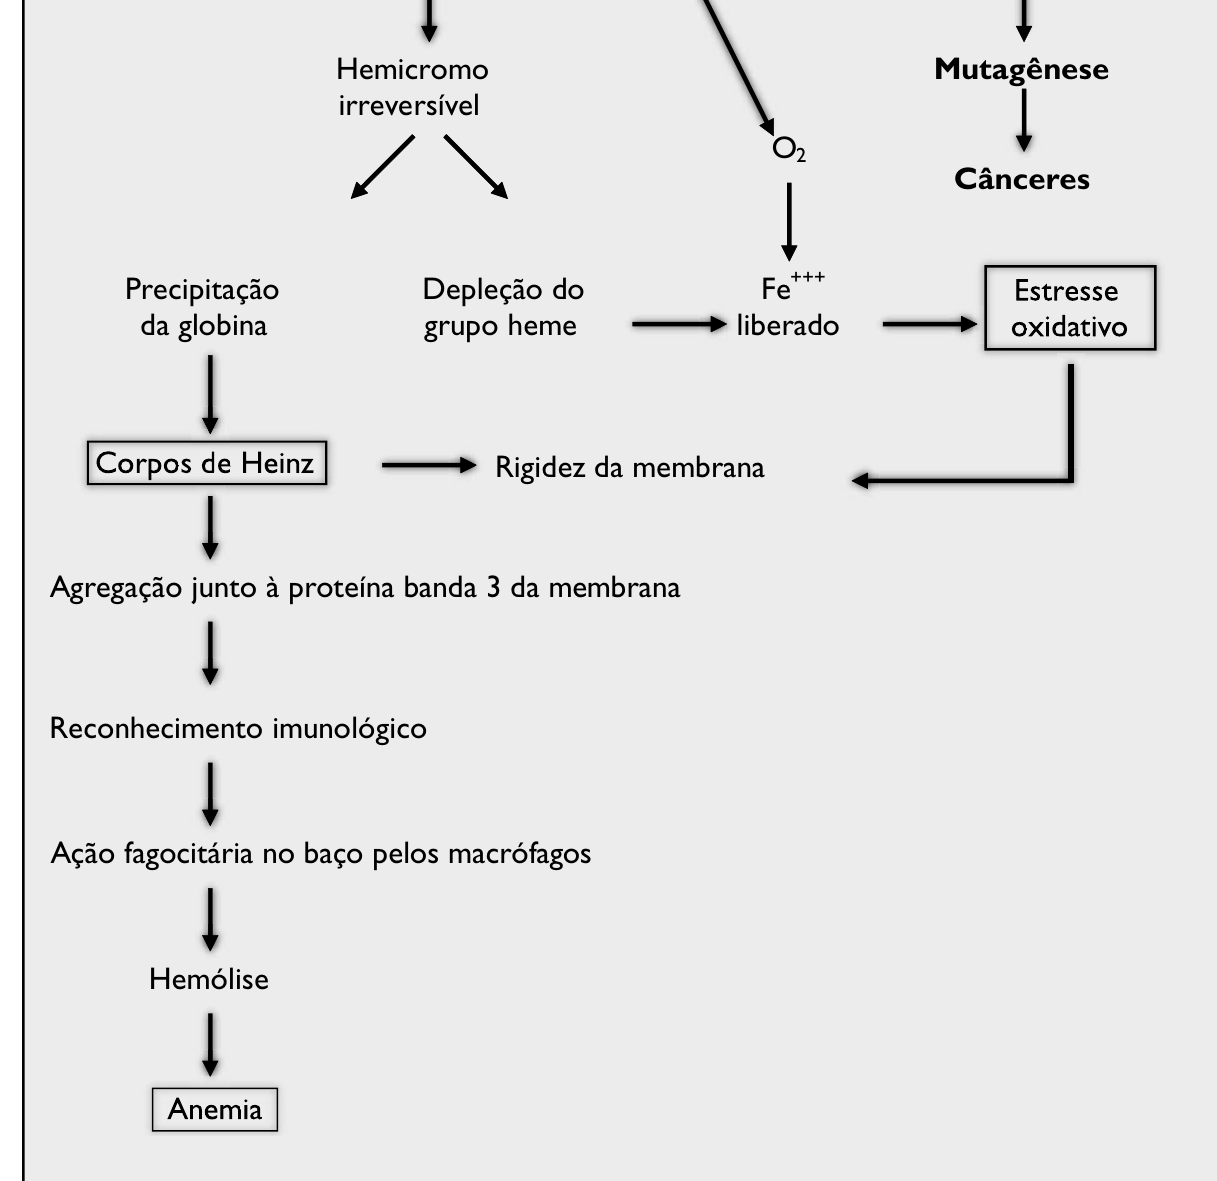
Figura 1 – Oxidação da hemoglobina resultando em produtos de degradação (metemoglobina, hemicromos e corpos de Heinz) e geração de radicais livres (O • , H O , HO e Fe +++ 2 2 2